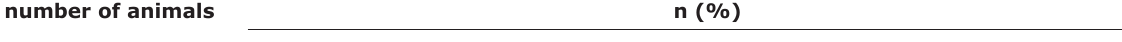
Table-1: Animal profile according to their FEC. Total number of